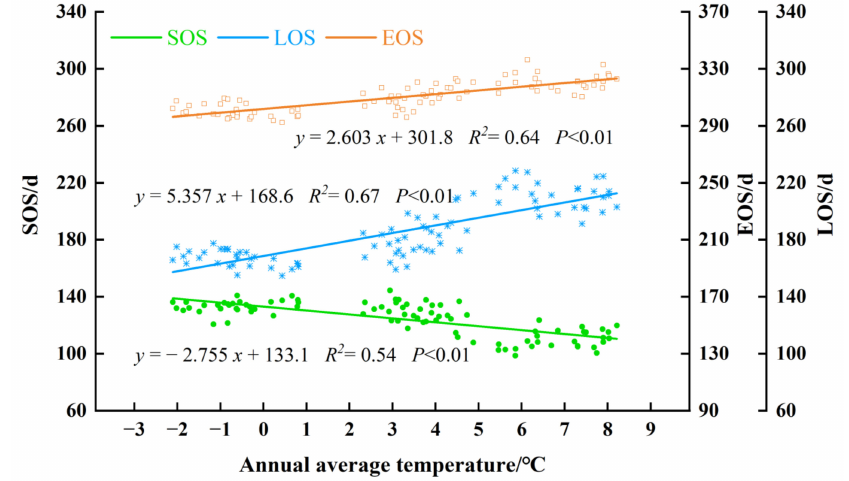
Figure 19. Responses of forest phenology to the annual mean temperature in different forest types in northeast China from 2011 to